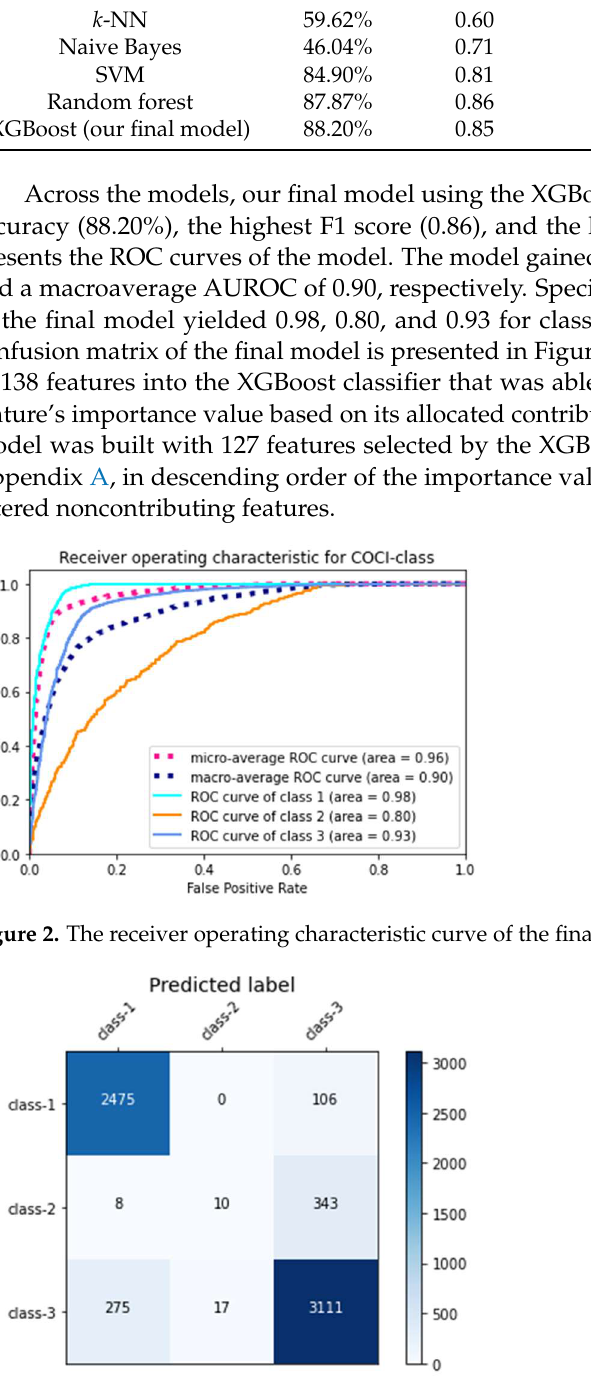
Figure 3. The confusion matrix of the final model.